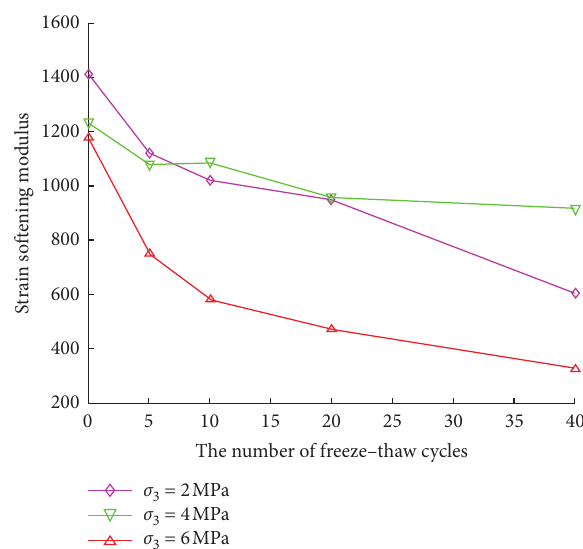
Figure 4: Effect of freeze-thaw cycle on strain softening